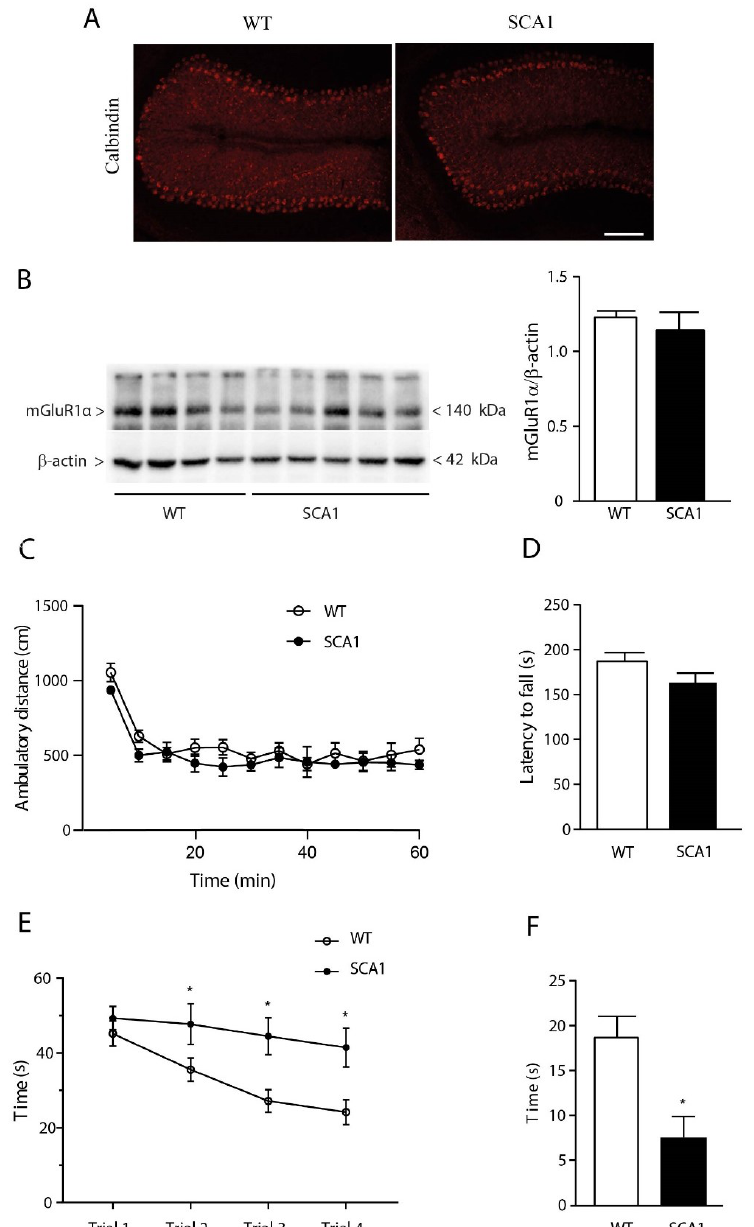
Figure 1. Impaired spatial learning and memory in 8-week-old SCA1 mice showing no cerebellar abnormalities. Calbindin immunostaining of cerebellar Purkinje cells in 8-week-old SCA1 mice and wild-type littermates is shown in ( A ). Scale bar: 100 µm. Immunoblot analysis of mGlu1α receptors in the cerebellum is shown in ( B ), where values are means ± S.E.M. of 4–5 mice; motor performance in the open-field apparatus is shown in ( C ), where values are means ± S.E.M. of 6–11 mice; motor coordination in the rotating rod is shown in ( D ), where values are means ± S.E.M. of 6–11 mice; spatial learning and memory retention in the two genotypes are shown in ( E) and ( F ), respectively, where values are means ± S.E.M. of 7–13 mice. * p < 0.05 vs. the respective values obtained in wild-type mice. Statistical analysis was performed by two-way ANOVA for repeated measures + Bonferroni test in ( E ) and Student’s t -test in ( F ). In ( E ): genotype, F 1,18 = 9.573, p = 0.0063; time, F 3,54 = 8.648, p < 0.0001; interaction, F 3,54 = 2.035, p = 0.1198; subject, F 18,54 = 3.565, p = 0.0002. In (F), t 18 =